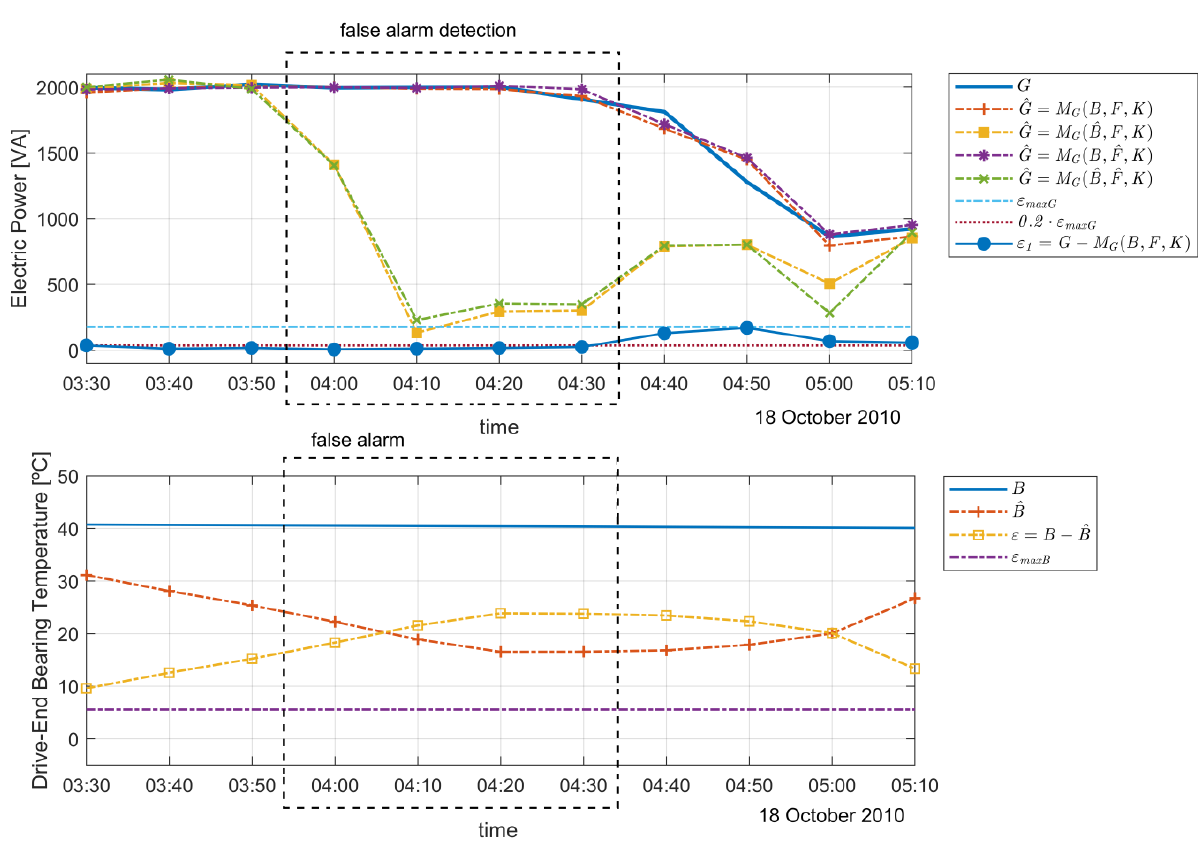
Figure 11. False alarm detection.